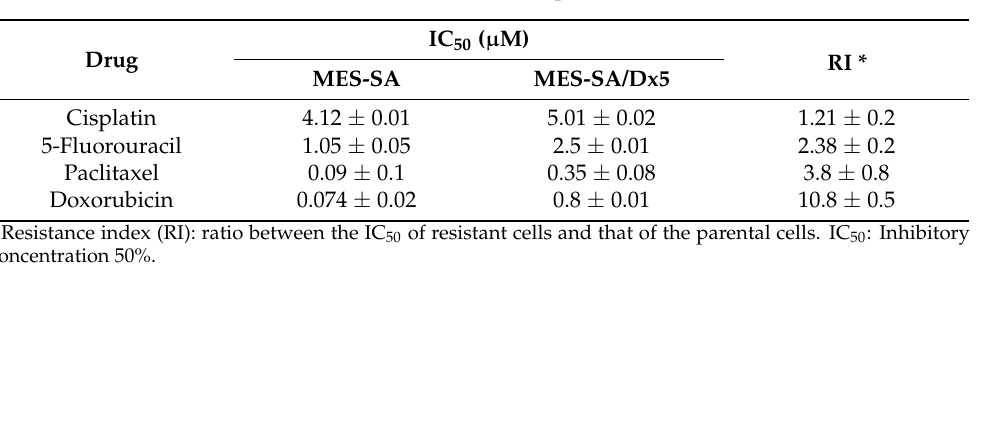
Table 1. The resistance index (RI) for various